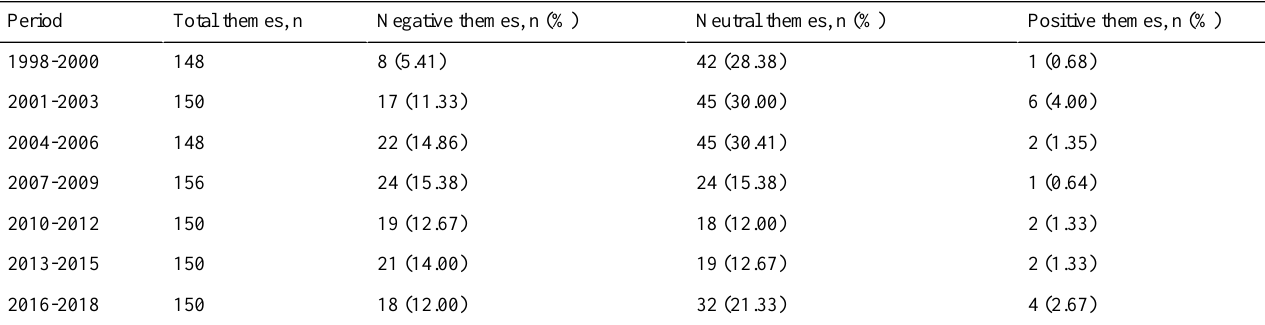
Table 2. Frequency of negative, neutral, and positive themes in music videos based on 3-year intervals.